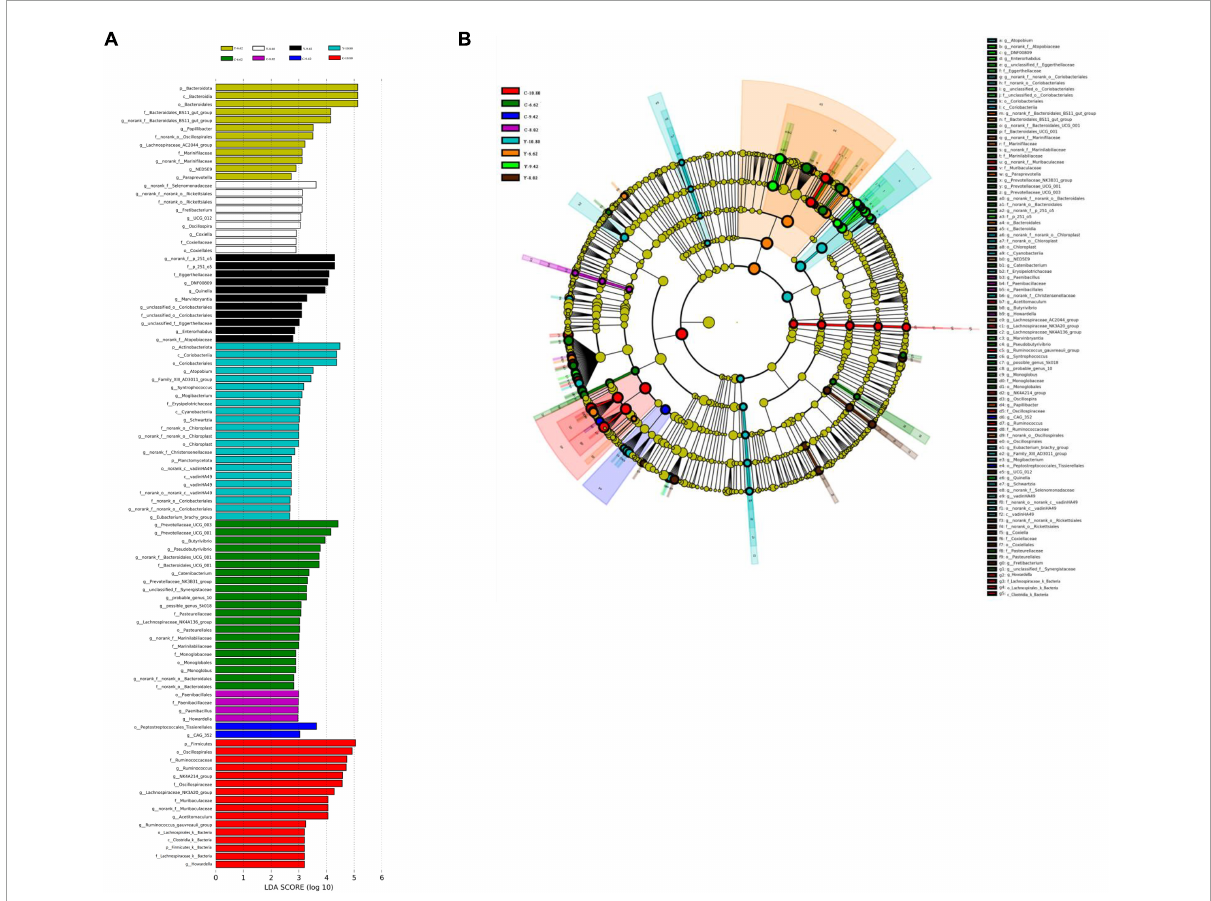
FIGURE6 Linear discriminant analysis effect size (LEfSe) results for rumen microbiota in yaks consuming diets with different energy levels (MJ ME/kg DM). (A) Linear discriminant analysis. (B) Cladogram reported. Prefixes represent abbreviations for the taxonomic rank of each taxon, class (c − ) order (o − ), family (f − ) and genus (g −